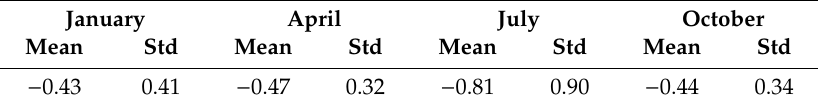
Table 1. The average and standard deviations in the area of ∆ δ < 0 ( % )